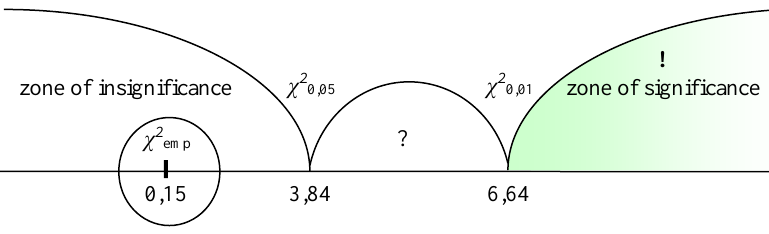
Figure 2: The Pearson’s 𝑐ℎ𝑖 2 test’s significant axis for the cognitive criterion (before the